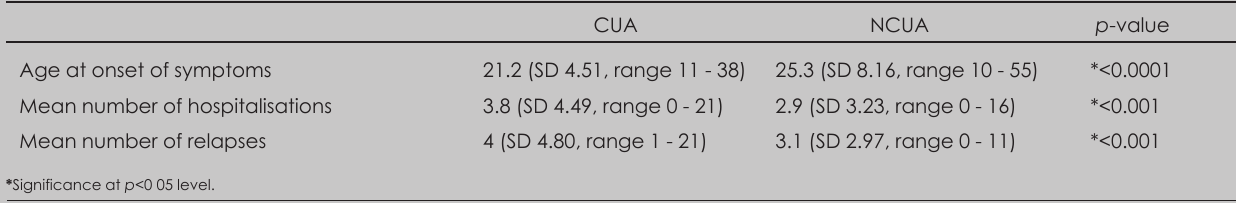
Age at onset of